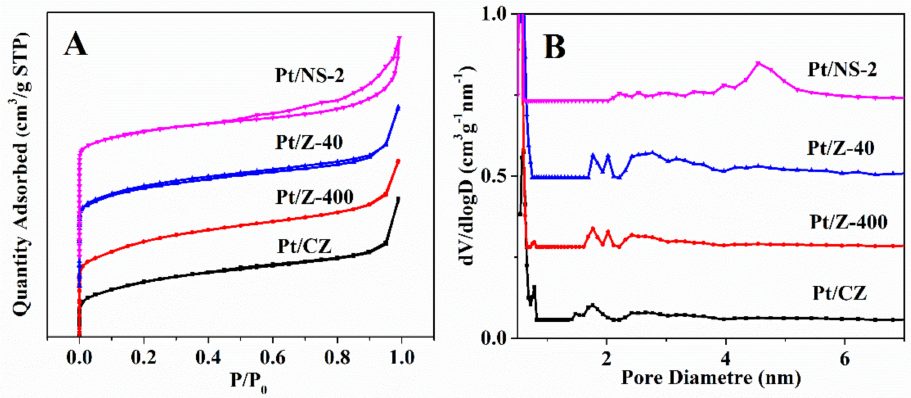
Figure5. ( A )N 2 physisorptionisothermsand( B )poresizedistributionsofthePt-loadedzeolitecatalysts.